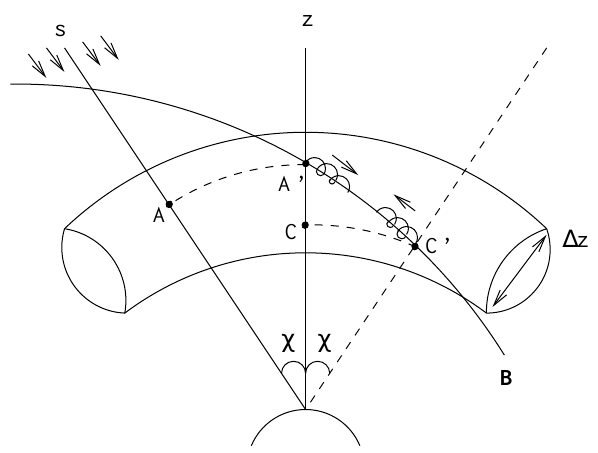
Fig. 3. Problem Geometry. The axis s is the solar-terrestrial axis. At an observation point at the surface of the Earth, the solar zenith angle is χ . The vertical axis at this point is z. The local magnetic field line is represented by the symbol B , and we consider an atmo- spheric slab of thickness